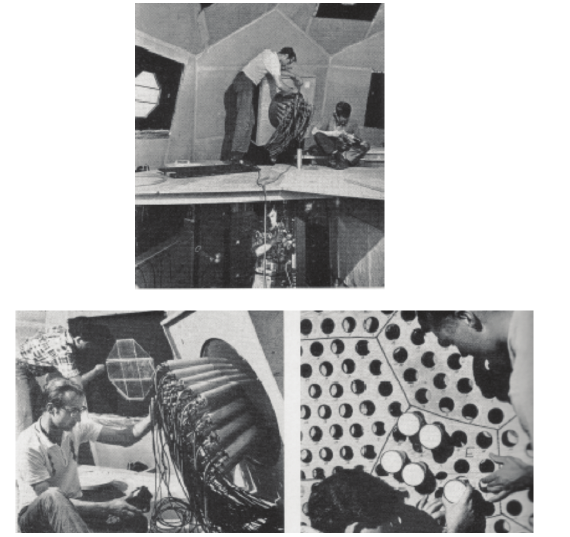
Figure 1. Greisen group prototype air-fluorescence